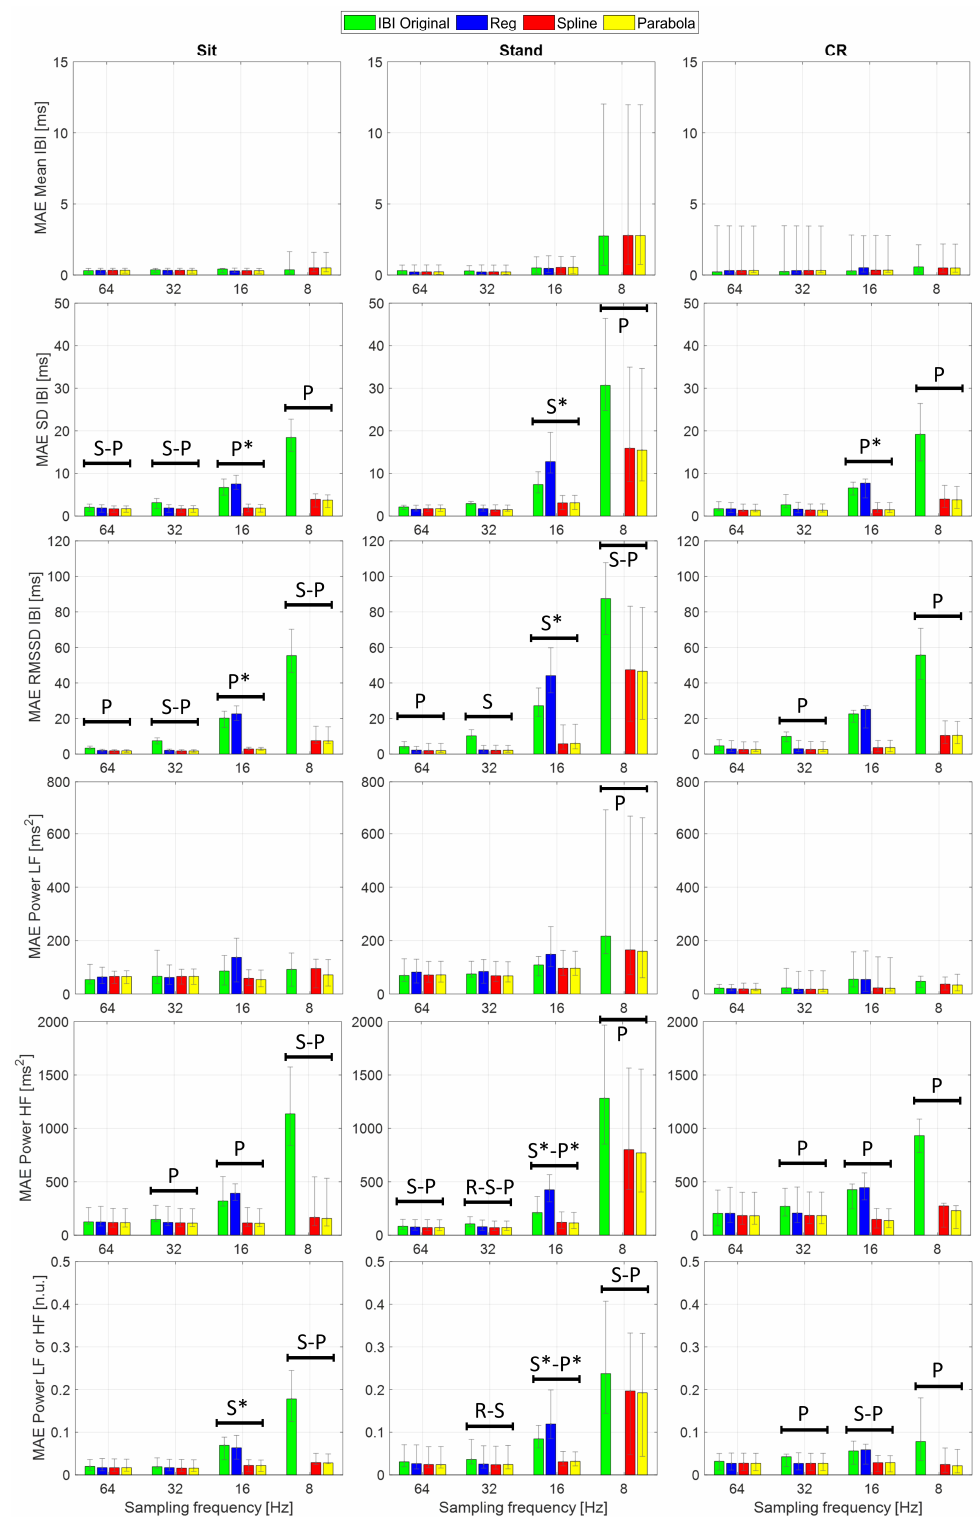
Figure 6. MAE (bars), upper, and lower quartiles (error bars) of the considered time- and frequency- domain features. R, S, and P indicate frequencies at which significant differences (Bonferroni- corrected, p < 0.05) were found between the original IBIs and REG (R), SPLINE (S), or PARABOLA (P) interpolations. All the reported differences show effect size (Cohen’s r ) > 0.5. *: Significant difference revealed after excluding